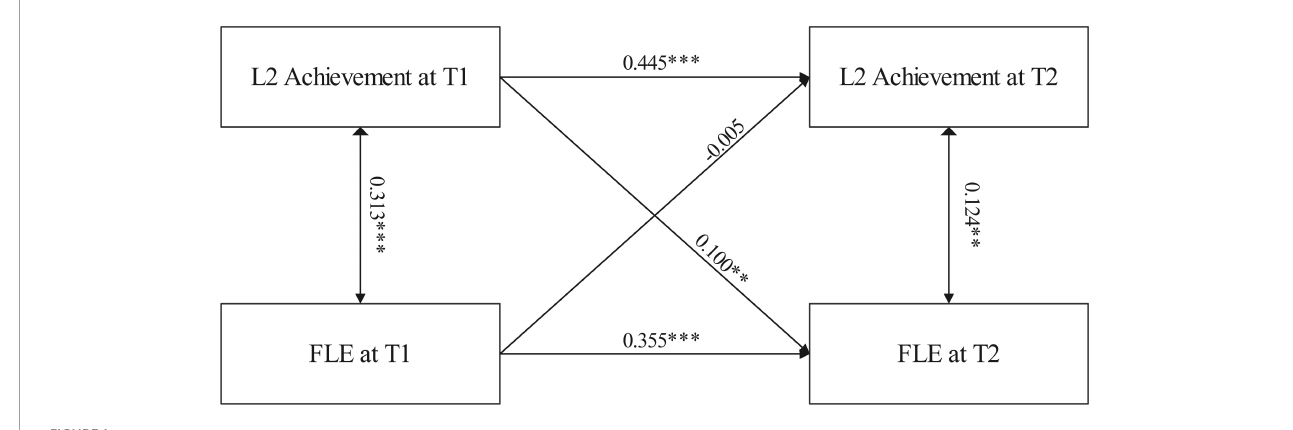
FIGURE1 Results of the cross-lagged panel analysis. ∗∗ p < 0.01, ∗∗∗ p < 0.001.